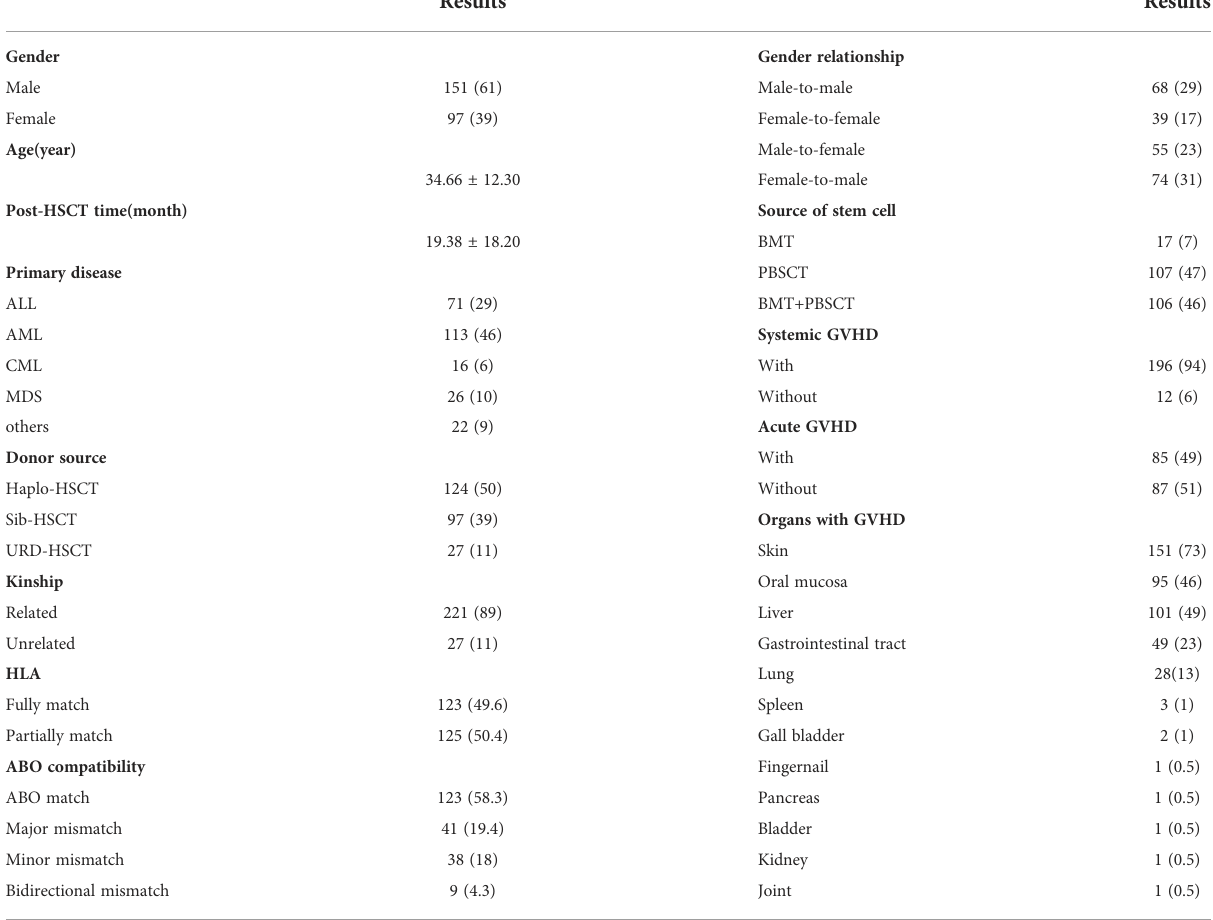
TABLE 2 Demographics and transplant